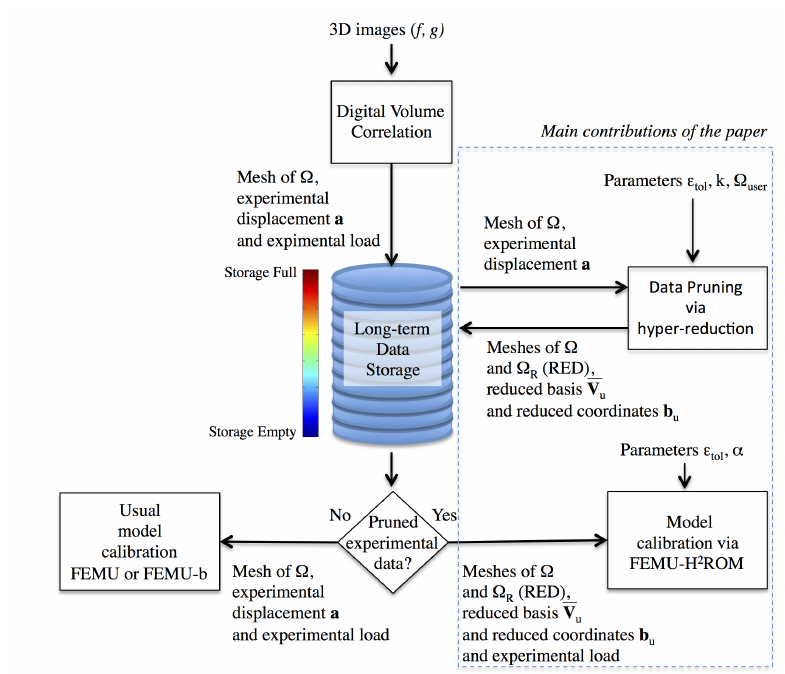
Figure 1. Pruning of experimental data related to DVC, via hyper-reduction. Calibration capabilities of constitutive equations are preserved after data pruning. The experimental data related to the domain occupied by a specimen, denoted by Ω , are restricted to a reduced experimental domain denoted by Ω R . The way the model calibration is done, depends on the nature of the data available in the storage